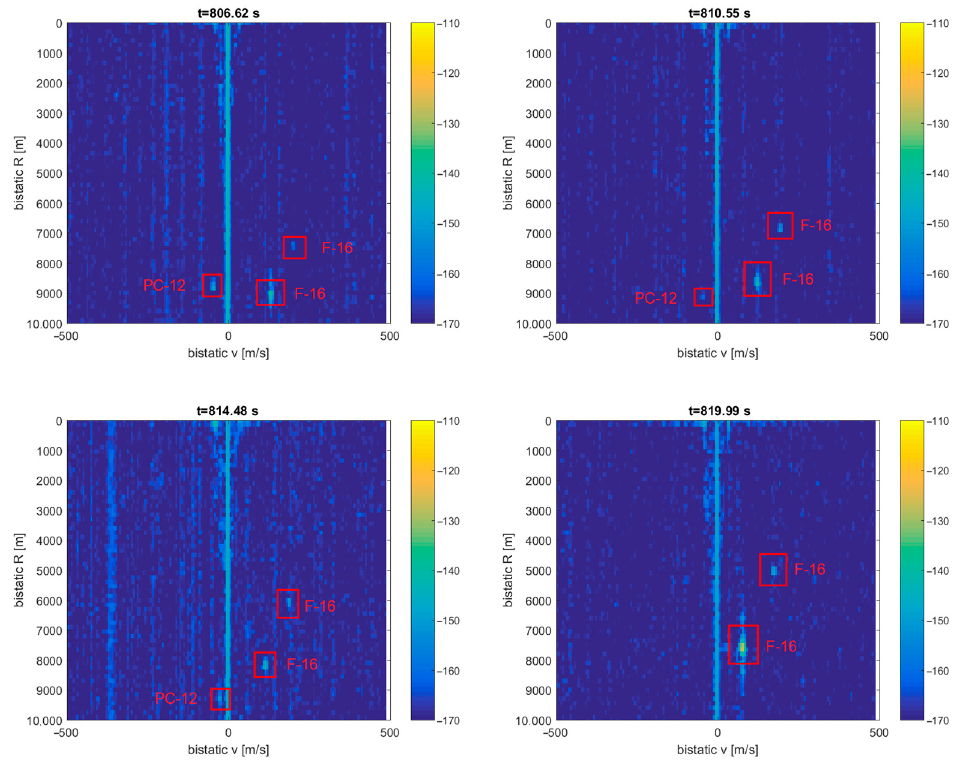
Figure 21. Detection results of the PILATUS PC-12 and two F-16 jet fighters (scene from Figure 20).